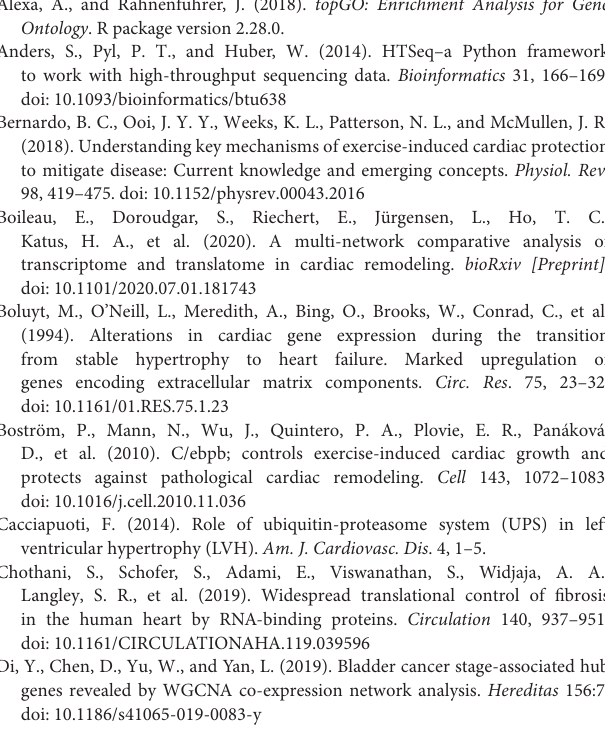
Supplementary Figure 1 | A survey of active translation in 15 mouse hearts representing models of cardiac remodeling. Supplementary Figure 2 | A survey of active translation in 15 mouse hearts: open reading frames (ORFs) translated in cardiac cells. Supplementary Figure 3 | Co-expression networks of transcriptional and translational regulation in cardiac remodeling: schematic workflow. Supplementary Figure 4 | Translatome (RNA) network modules were clustered to assess relatedness based on correlation of co-expressed eigengenes.